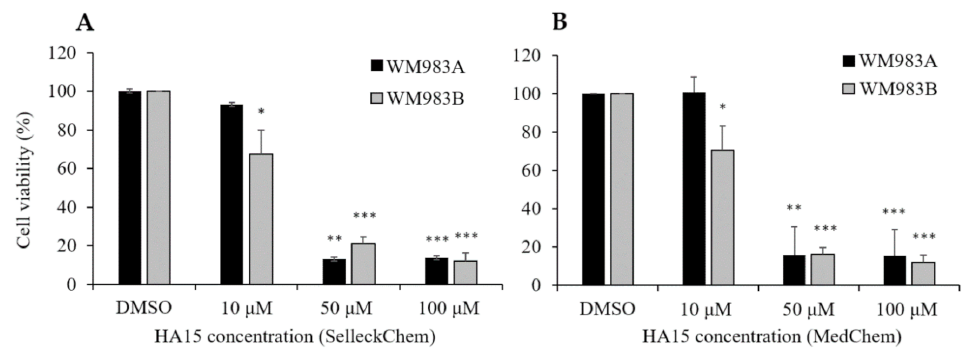
Figure 5. Viability of the WM983A and WM983B cell lines after treatment at different concentrations of drug (10, 50, 100 µ M of HA15). HA15 was obtained from two different companies: Sellect Chemicals ( A ) and MedChemExpress ( B ). Before treatment, cells were starved for 14 h; after starvation, different concentrations of HA15 were added to the cell cultures in complete medium. Data represent the mean viability of three independent experiments ± SD and are expressed as percentages of the control. Asterisks indicate significant differences: * p < 0.05; ** p < 0.01; *** p <